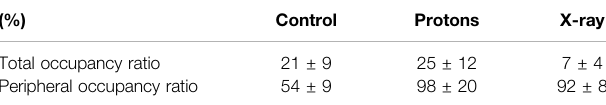
TABLE 1 | Computed total and peripheral occupancy